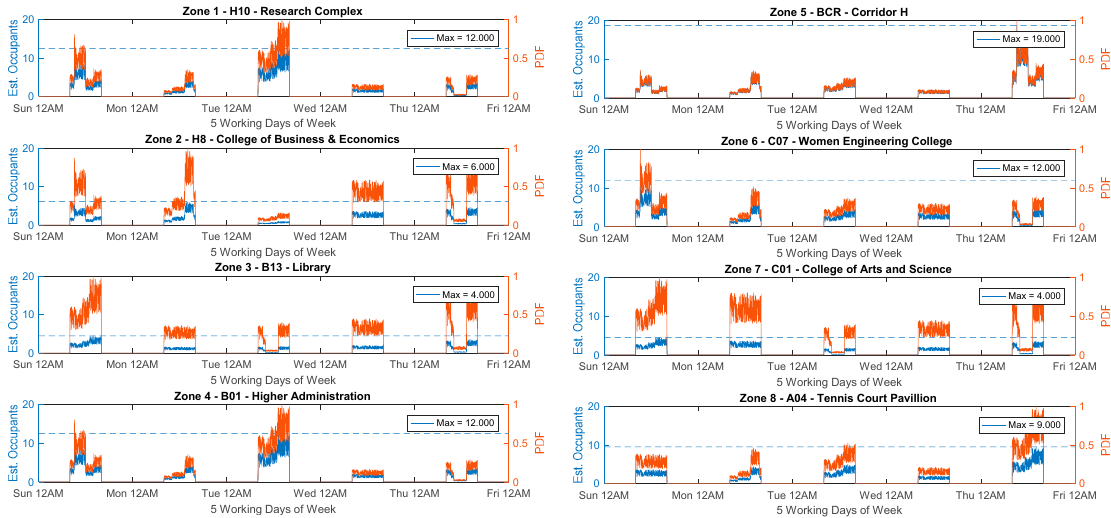
Figure 13. SHM Building Evaluation Graph.